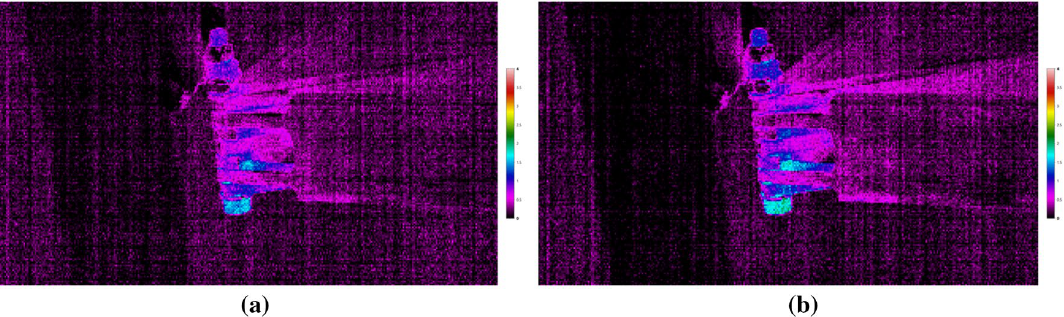
Fig. 22 The a first and b second snapshots from the final test using the second mode of